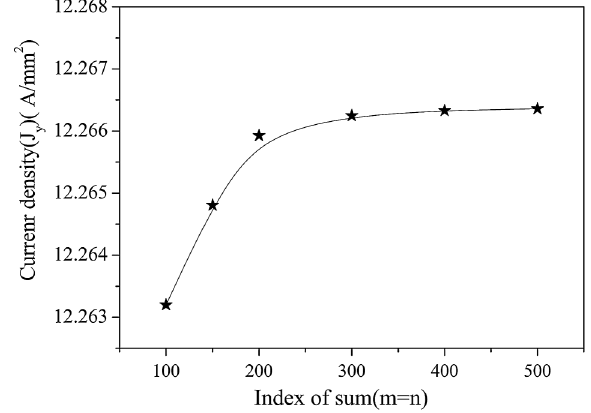
FIG. 3. Evaluation of the eddy current from analytical expres- sions for different indices of the sum ( m ¼ n ) in Eq. (17). The solid line is just a guide to the eye.